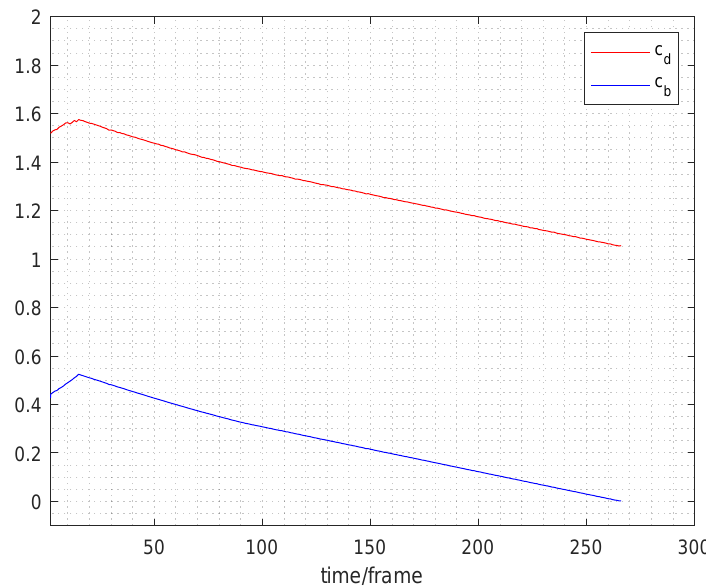
Figure 5. Typical values of the cost function in the locked-up localization